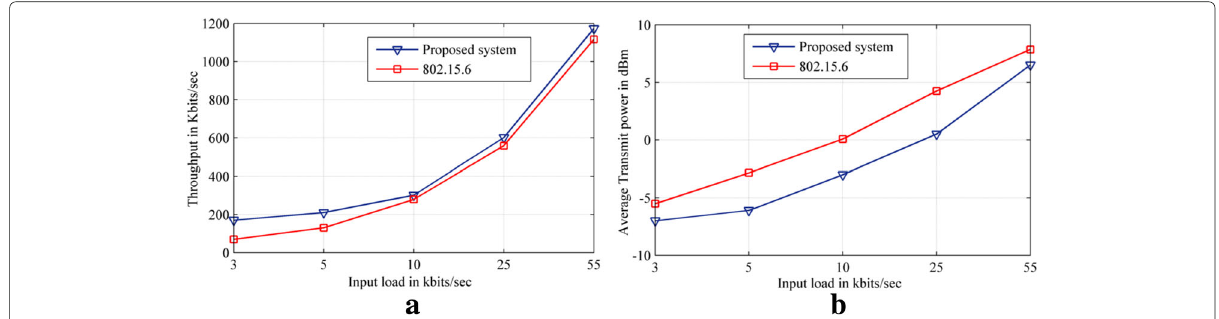
Fig. 13 Throughput and power comparison with 802.15.6 slotted aloha. a Throughput comparison. b Average data transmission power